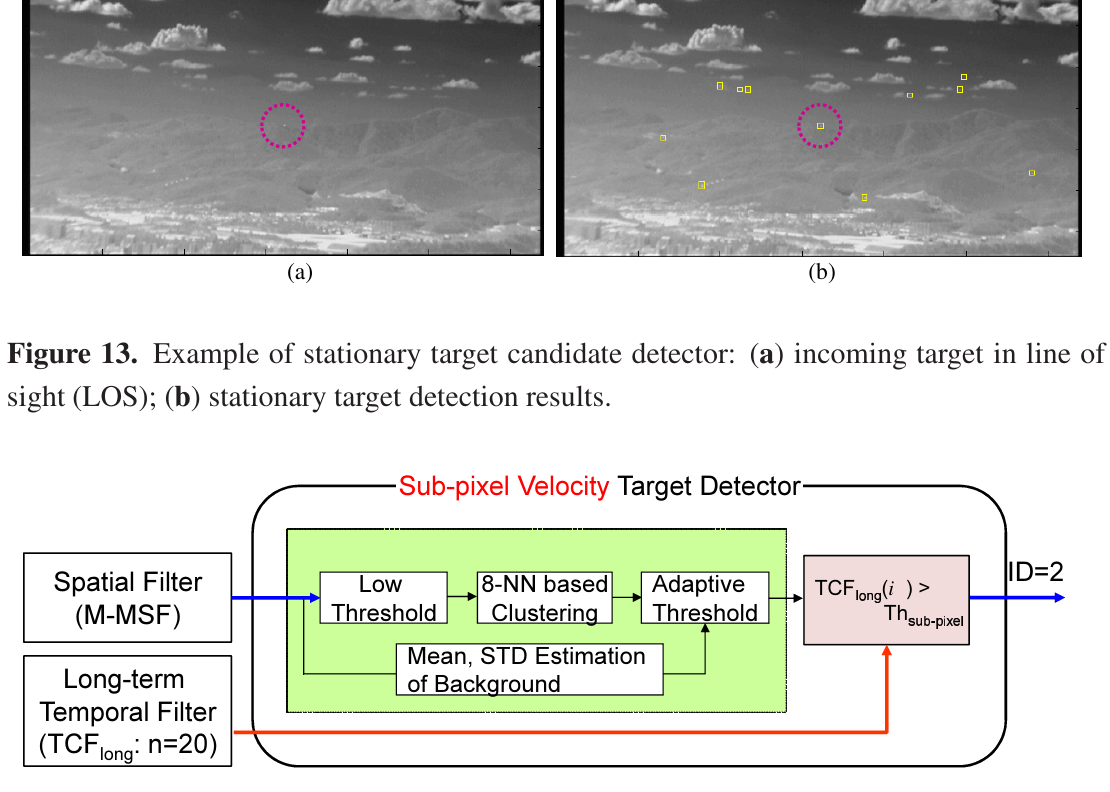
Figure 14. Sub-pixel velocity target candidate detector: given M-MSF filtered image, the spatial targets are detected using an H-CFAR detector. Slowly moving targets are detected using the long-term TCF